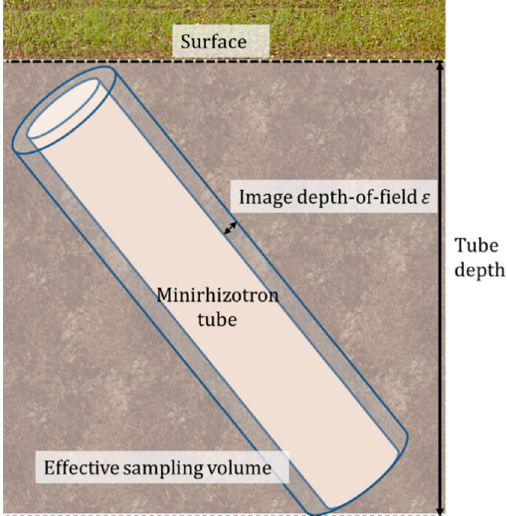
Figure 3. Principle of the conversion of root length surface density into root biomass. The minirhizotron tube is surrounded by the effective sampling volume considered for the conversion of root length densities to root biomasses. This effective sampling volume, represented by a blue shade, is a cylindrical shell of inner radius equals to the tube outer radius and of thickness ε , i.e., the image depth-of-field acquired by the scanner-based minirhizotron.